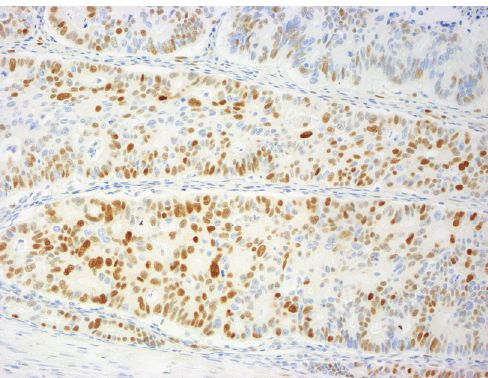
Figure 1: Representative example of immunopositivity grade 3 for cyclin A (original magnification × 200).